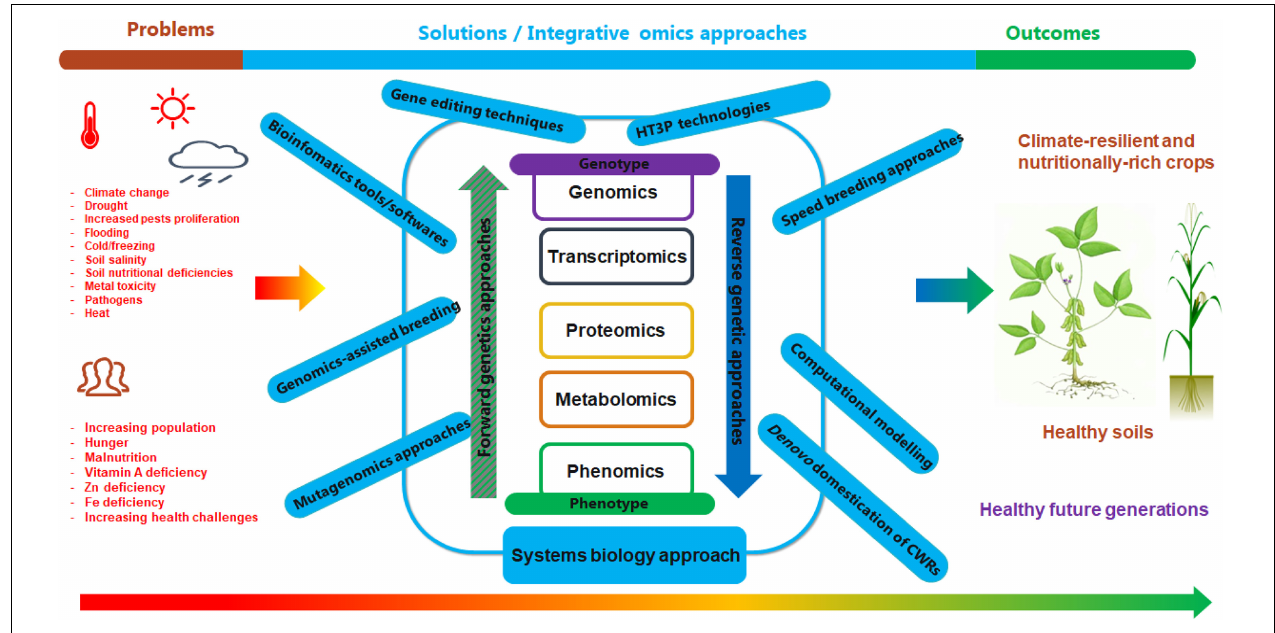
FIGURE 2 | Abstract illustration of the role of integrated omics approaches in anchoring the development of climate-smart future crops. Integrated multi-omics strategies coupled with forward and reverse genetics methods, as well as advanced plant breeding, gene editing, mutagenomics and computational modeling techniques in a systems biology approach facilitate for the creation of climate-resilient and nutrition-rich crops. HT3P, high-throughput plant phenotyping platforms; CWRs, crop wild relatives.